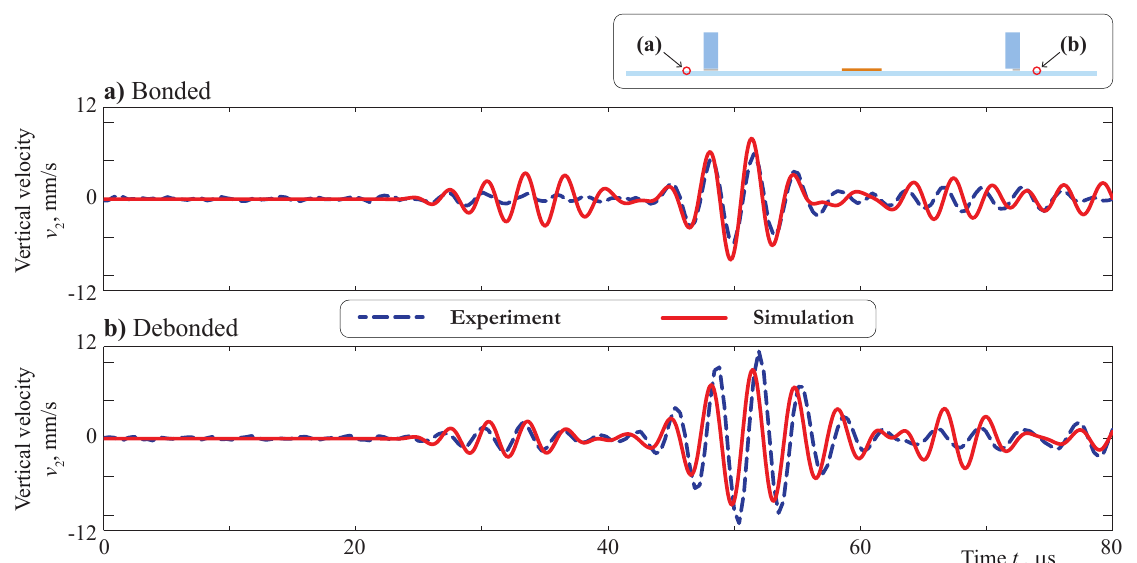
Figure 5. Vertical velocities at the surface of the plate for bonded ( a ) and debonded ( b ) obstacles, which were measured and calculated at central frequency f = 300 kHz at the points x 1 = ± 130